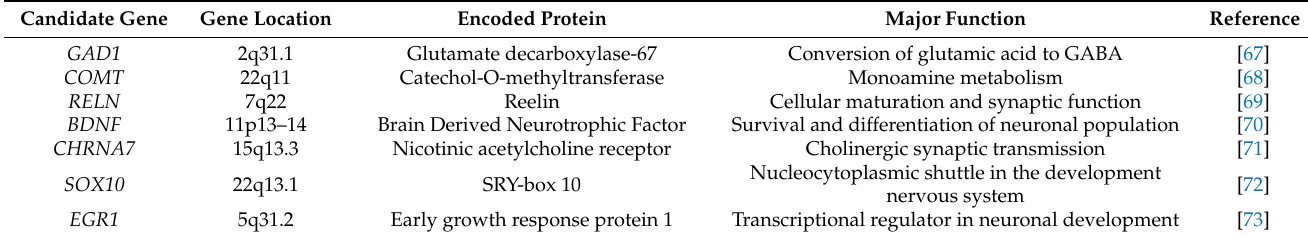
Table 1. Summary of some of the candidate gene methylations for